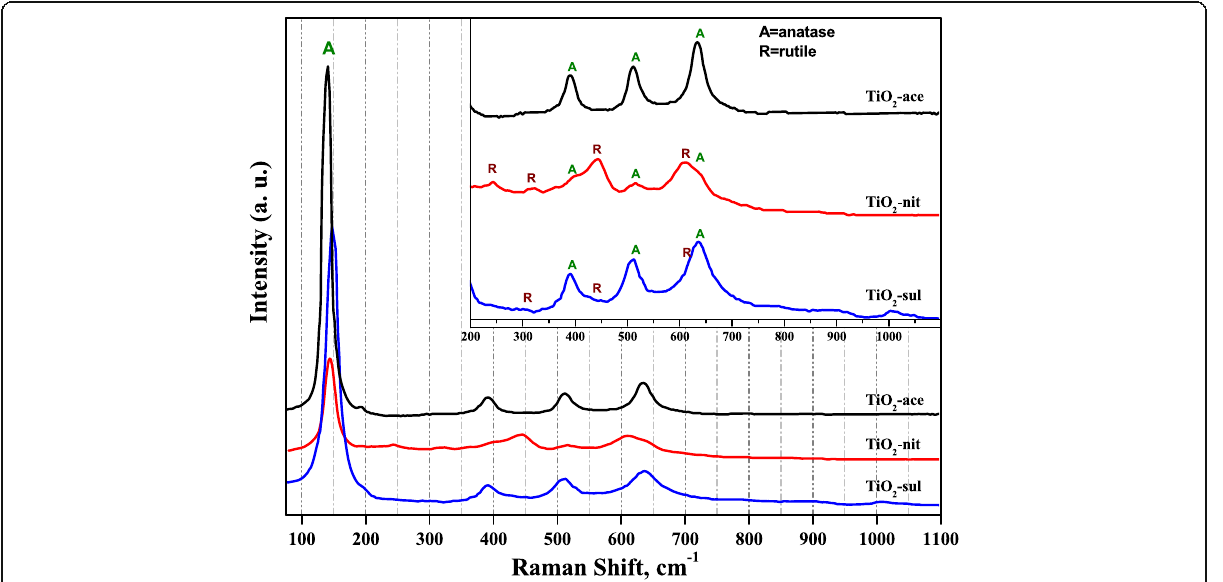
Fig. 3 Raman spectra of the calcined TiO 2